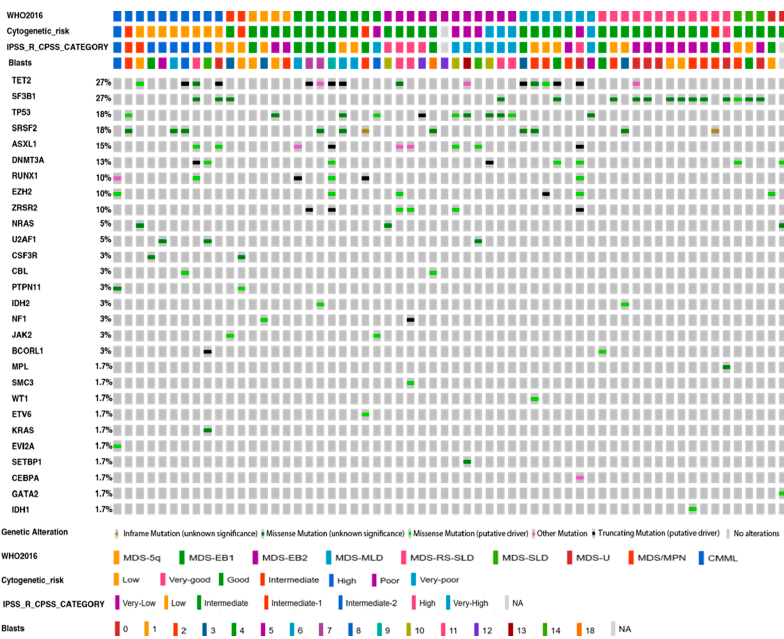
Figure 1. Distribution of clinically relevant variants of significantly mutated genes in 60 MDS/CMML cases. Pathogenic and likely pathogenic variants (SNVs and indels) identified in 28